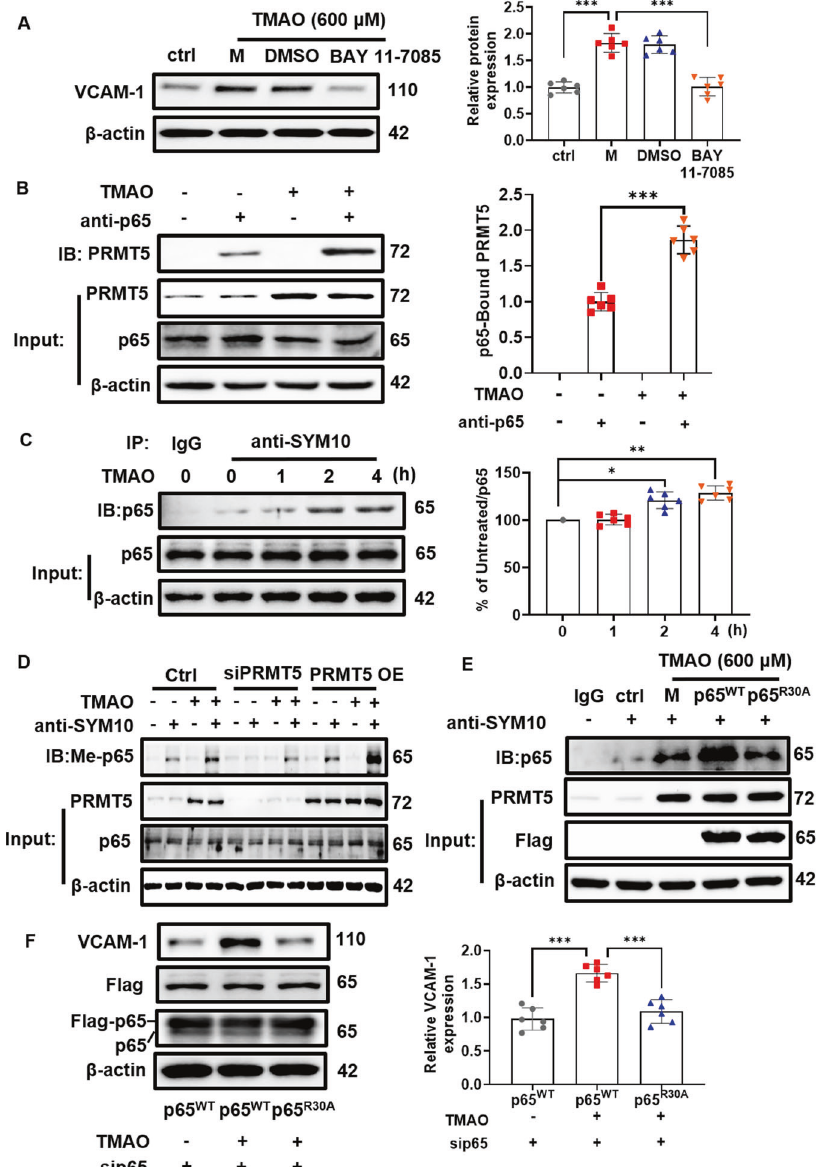
protein expression level was normalized to β -actin. B VSMC were treated with TMAO (600 μ M) for indicated periods. Co-immunoprecipitation analysis of the interaction between PRMT5 and p65. C VSMC were treated with TMAO (600 μ M) for 24 h. Representative blots of arginine methylation of p65. Immunoprecipitated SYM10 was blotted with an antibody against p65. D Representative blots of arginine methylation of p65. Immunoprecipitated SYM10 was blotted with an antibody against p65 in VSMC transfected with PRMT5 siRNA (siPRMT5) or PRMT5 cDNA plasmid (PRMT5 OE) followed by TMAO (600 μ M) stimulation. E Flag-tagged p65 wide-type (p65 WT ) or R30A mutant (p65 R30A ) plasmid was transfected to VSMC, and then treated with TMAO (600 μ M). Representative blots of arginine methylation of p65. Immunoprecipitated SYM10 was blotted with an antibody against p65. F Flag-tagged p65 wide-type (p65 WT ) or R30Amutant (p65 R30A ) plasmid was transfected to VSMC, and then treated with TMAO (600 μ M). Representative blots and quantitative analysis of VCAM-1. The protein expression level was normalized to β -actin. Data shown are means ± SD, n = 6 per group from three independent experiments. * P < 0.05, ** P < 0.01, *** P < 0.001 using a one- way ANOVA followed by Tukey ’ s post hoc